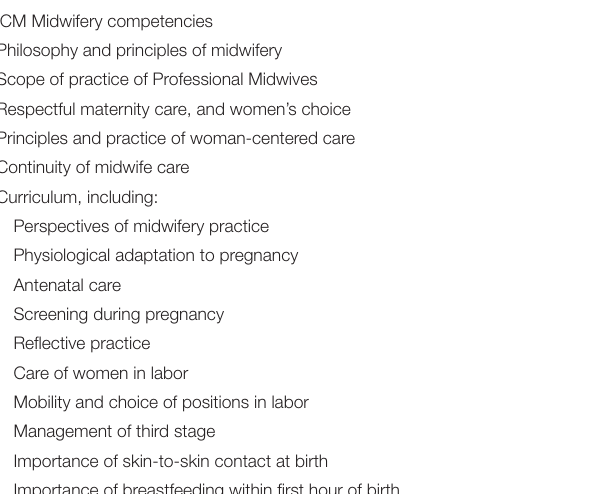
TABLE 2 | Key elements of the Professional Midwifery Education